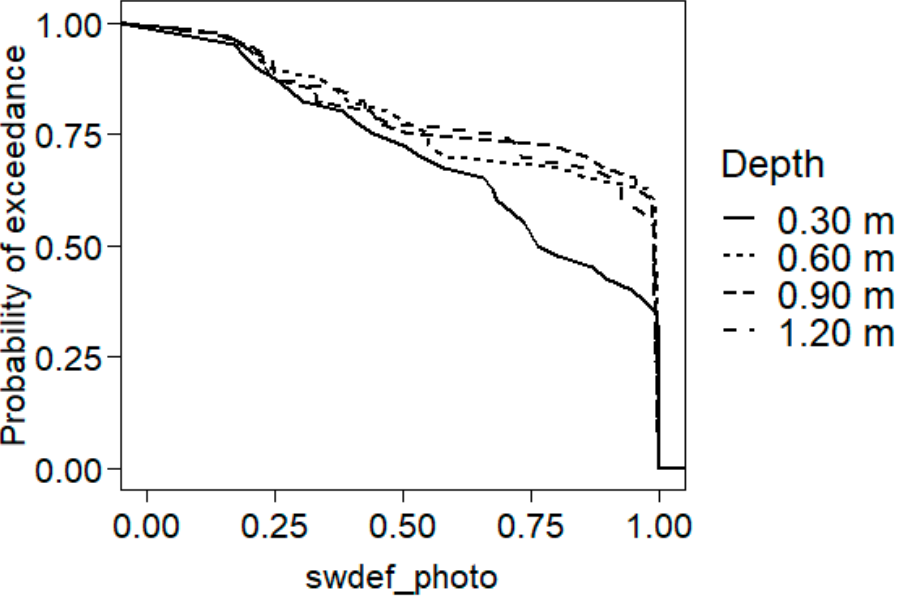
Figure 13. Simulated water stress index (swdef_photo) for AAMinor at different rooting depth, August sowing window and fertilization treatment 75 kg N ha − 1 .